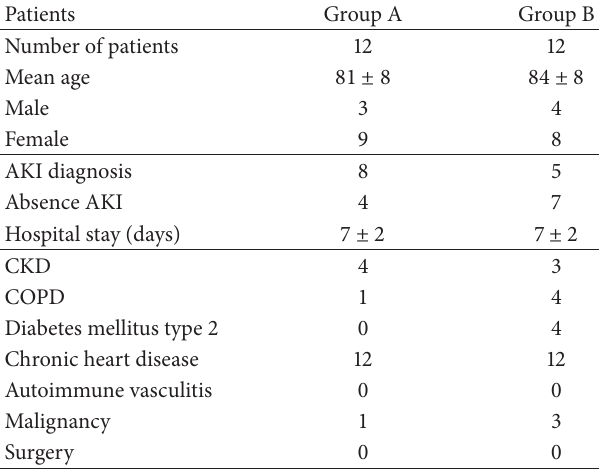
Table 1: Characteristics of the study population: a case series of 24 patients with acute decompensated heart failure